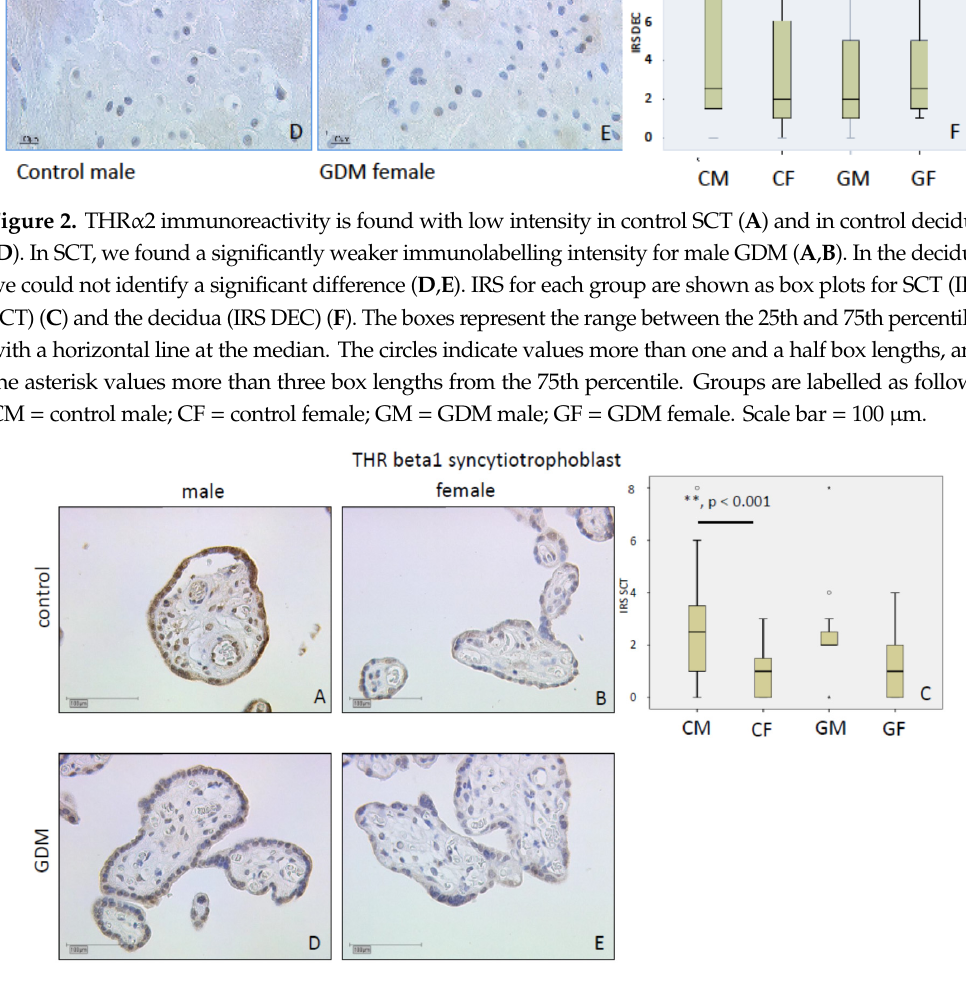
Figure 4. THR β 1 immunoreactivity is found with median intensity in decidua in controls ( A , B ) and in GDM ( D , E ). IRS for each group are shown as box plots for the decidua (IRS DEC) ( C ). The boxes represent the range between the 25th and 75th percentiles with a horizontal line at the median. The circles indicate values more than one and a half box lengths, and the asterisk values more than three